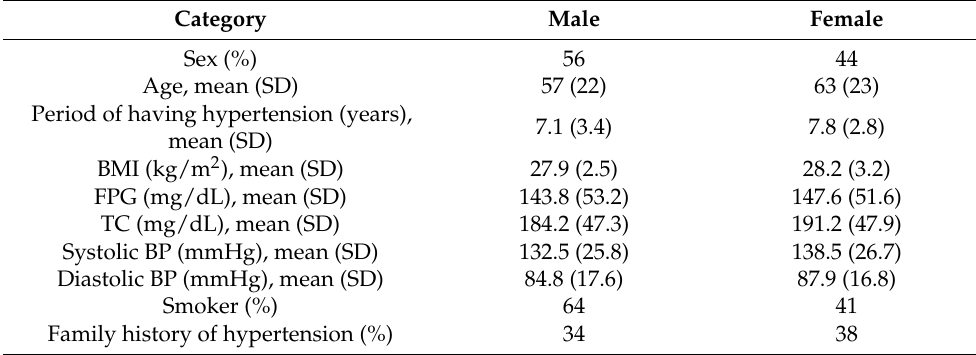
Table 1. Statistics of data set